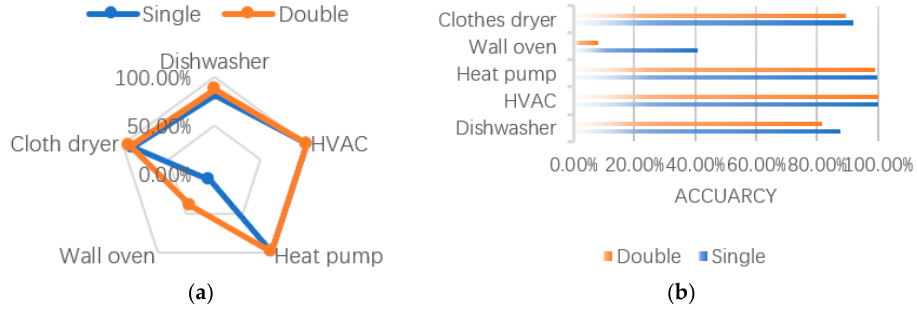
Figure 10. ( a ) Radar charts with five loads (CDE, DWE, FRE, HPE, and WOE) accuracy in AMPds2. ( b ) Histogram charts with five loads accuracy. “Single” means that only power measurements were used, while “Double” means that power measurements and current signals were both included.